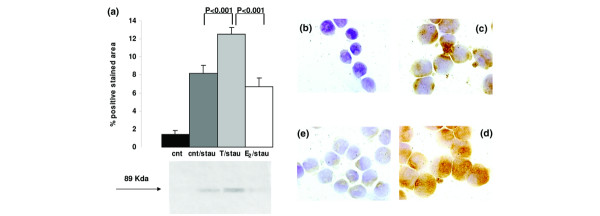
Poly-ADP-ribose polymerase (PARP)-cleaved expression in cultured human THP-1 cell line. (a) Poly-ADP-ribose polymerase (PARP)-cleaved expression in the cultured human THP-1 cell line in basal conditions and after 168 hours of hormonal treatment and staurosporine (stau). Results are expressed as the mean ± standard deviation of the percentage of the positive area for 100 cells in five different experiments. Bottom: western blot analysis related to PARP-cleaved expression in untreated cells (basal condition) and cells treated with hormones and staurosporine. (b) PARP-cleaved expression in THP-1 cells (basal condition). (c) PARP-cleaved expression in THP-1 cells after normal medium. (d) PARP-cleaved expression in THP-1 cells after testosterone (T) treatment. (e) PARP-cleaved expression in THP-1 cells after 17β-oestradiol (E2) treatment. cnt, control.